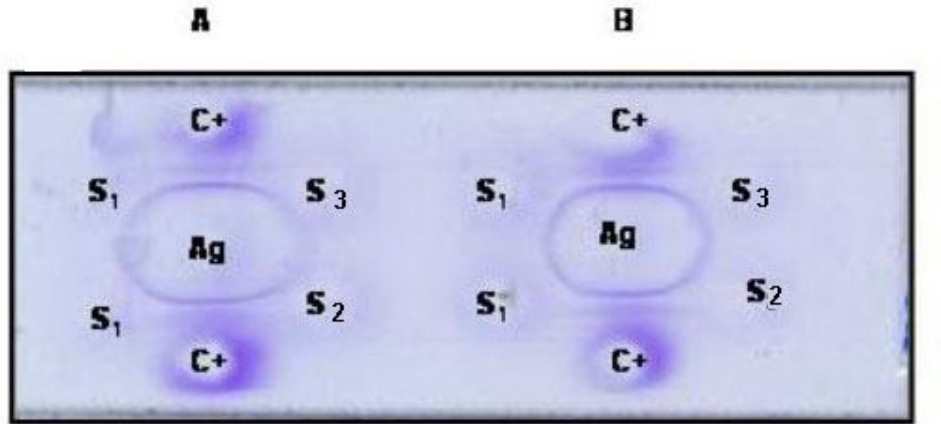
Figure 1. Qualitative immunodiffusion assay. Central wells present the antigen obtained from isolate 200 of H. capsulatum ( A ) and H. capsulatum reference antigen ( B ); peripheral wells have (C+) H. capsulatum control serum with bands H and M. Wells S , S and S contain patient serum samples evaluated before, during and 30 1 2 3 days after antimycotic therapy, respectively.